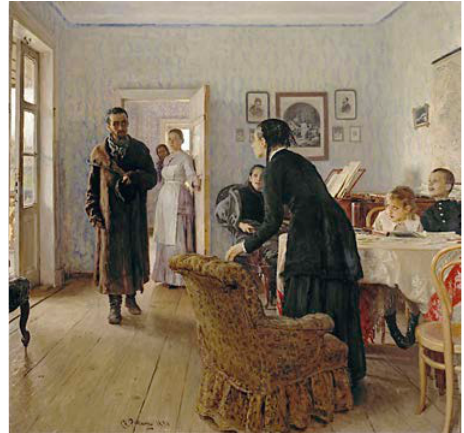
Figure 11. The painting Unexpected Visitors, by Ilya Re- pin, used by Yarbus in his classic work on eye movements (Yarbus 1967). For our experiments we used a full colour version of size 1024x980 pixels.